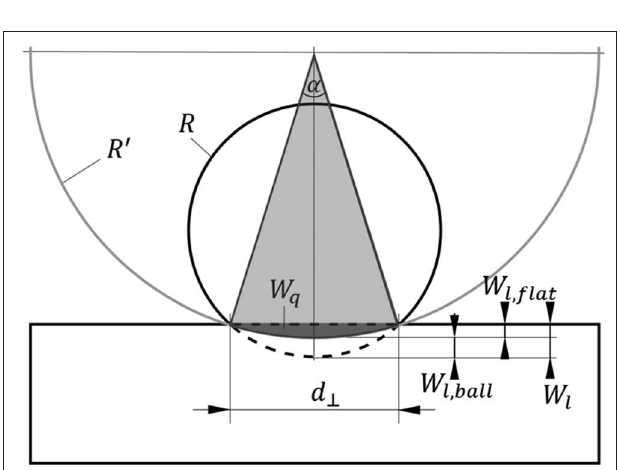
FIGURE 2 | Schematic representation of the geometry of the worn sphere and plane normal to the sliding direction. The figure shows the quantities used to calculate the radius of the curved worn surface R ′ in the friction test: radius of the ball R , wear track width d ⊥ , angle of the circular sector α , planimetric wear W q , total linear wear W l , and linear wear of ball and plane, W l , ball and W l , flat . The original surface profile lines of the sphere and plane are shown as dashed